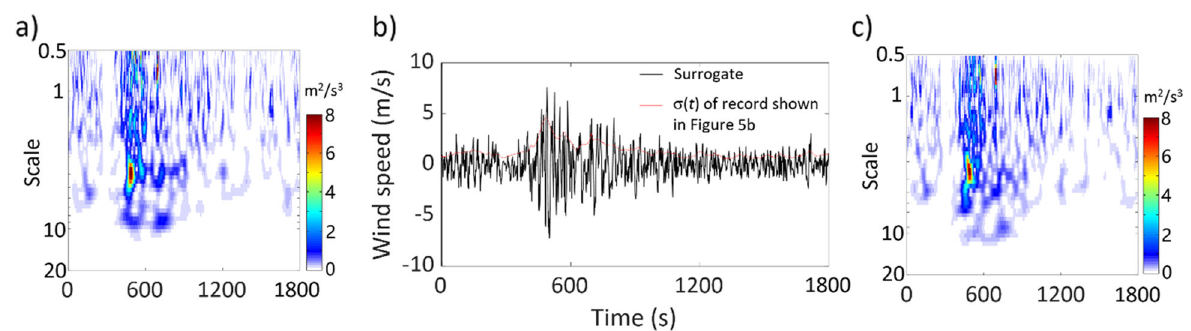
Fig. 7 Results by using WT for the wind record shown in Fig. 5b: a TSPSD of the given record, b a generated surrogate and σ ( t ) of the given record, and c TSPSD of the generated surrogate shown in Fig. 7b